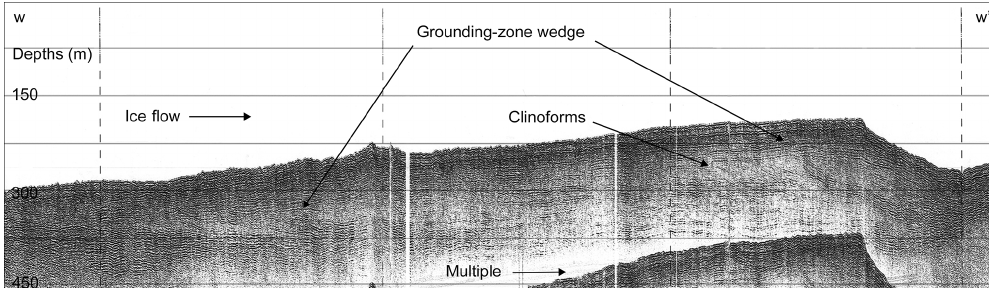
Figure 6. Seismo-stratigraphic (air gun) profile showing a major 75m thick grounding-zone wedge (red) in the inner to middle Sam Ford Trough (Profile 80028_AG_RAYT_257_0200; NRCan).